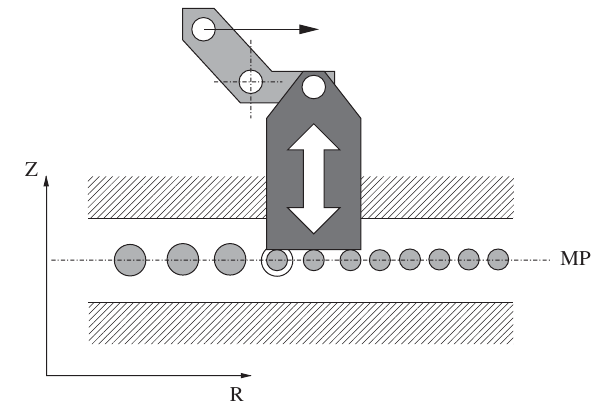
FIG. 4. Partial beam stripping by vertical positioning of a stripper foil keeping a certain distance to the median plane